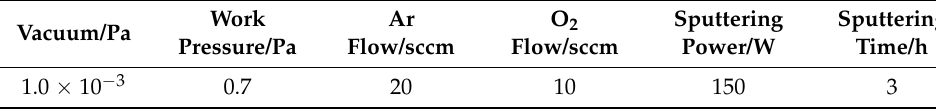
Table 3. Preparation technological parameters of the SiO 2 thin